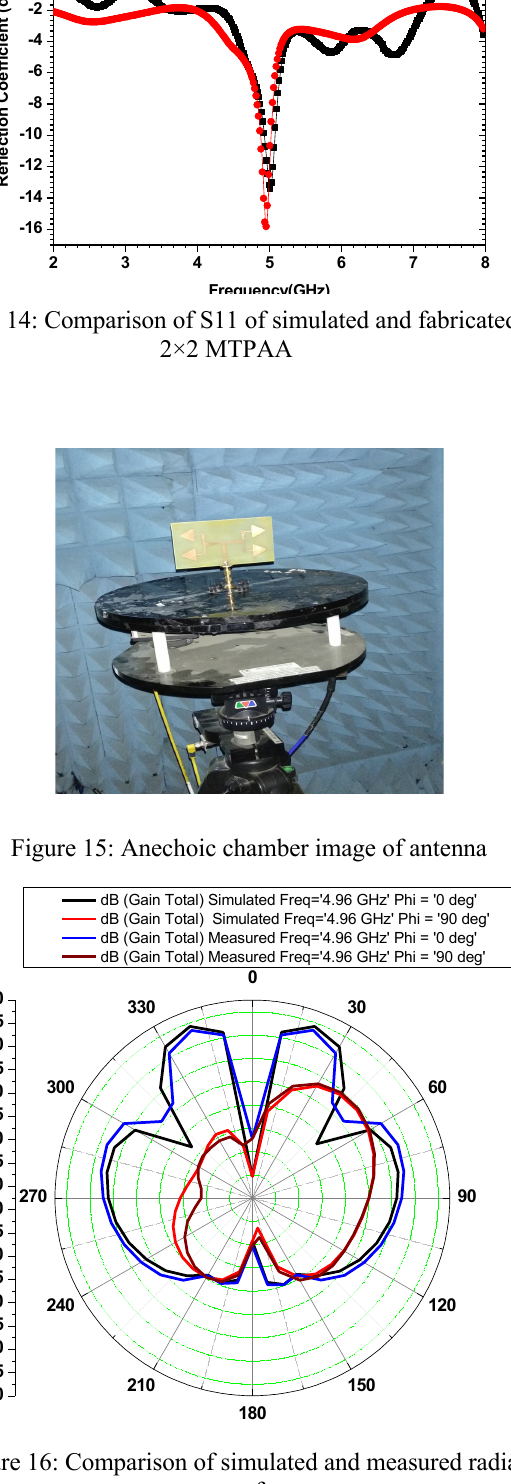
Figure 16: Comparison of simulated and measured radiation pattern of